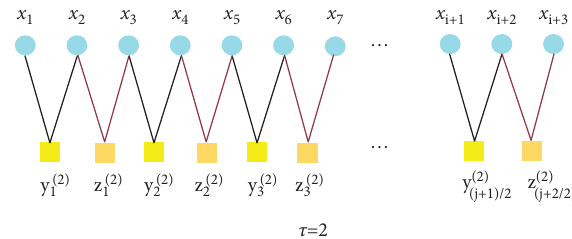
Figure 1: Coarse-grained procedure with scale factor to